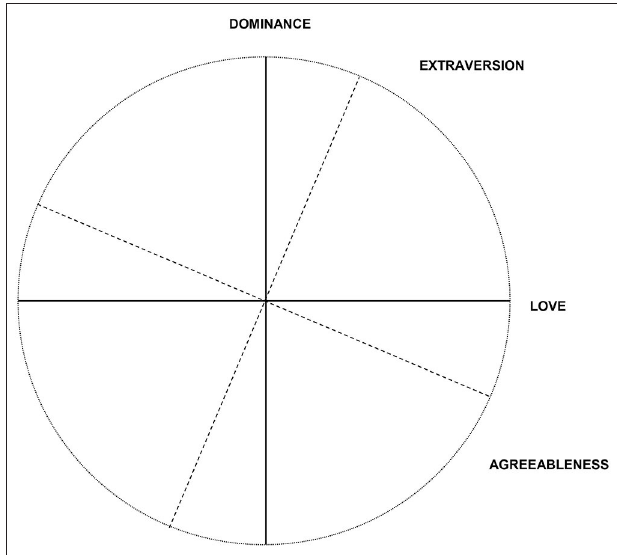
FIGURE 2 | Big Five agreeableness and extraversion within the interpersonal circumplex (see also DeYoung et al., 2013, adaptation